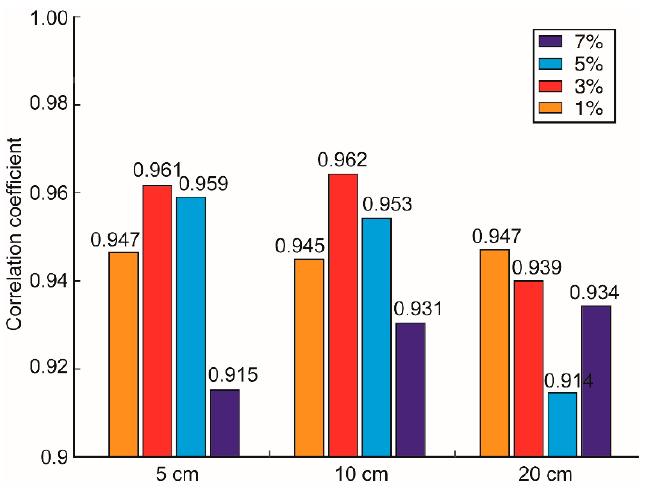
Figure 13. Comparison of correlation coefficients between stacked envelopes of the observed and synthetic LPR data. These correlation coefficients are listed in Table 1. Table 1. Correlation coefficients between Yutu-2 LPR data and synthetic data.